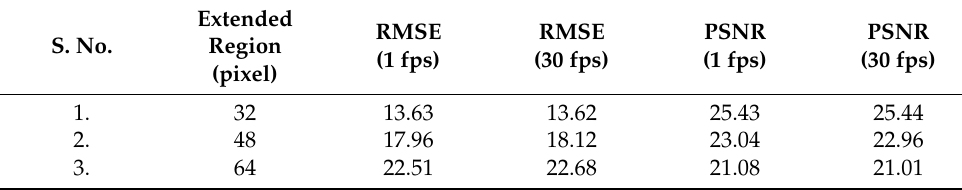
Table 3. The results for RMSE and PSNR for testing video frames.